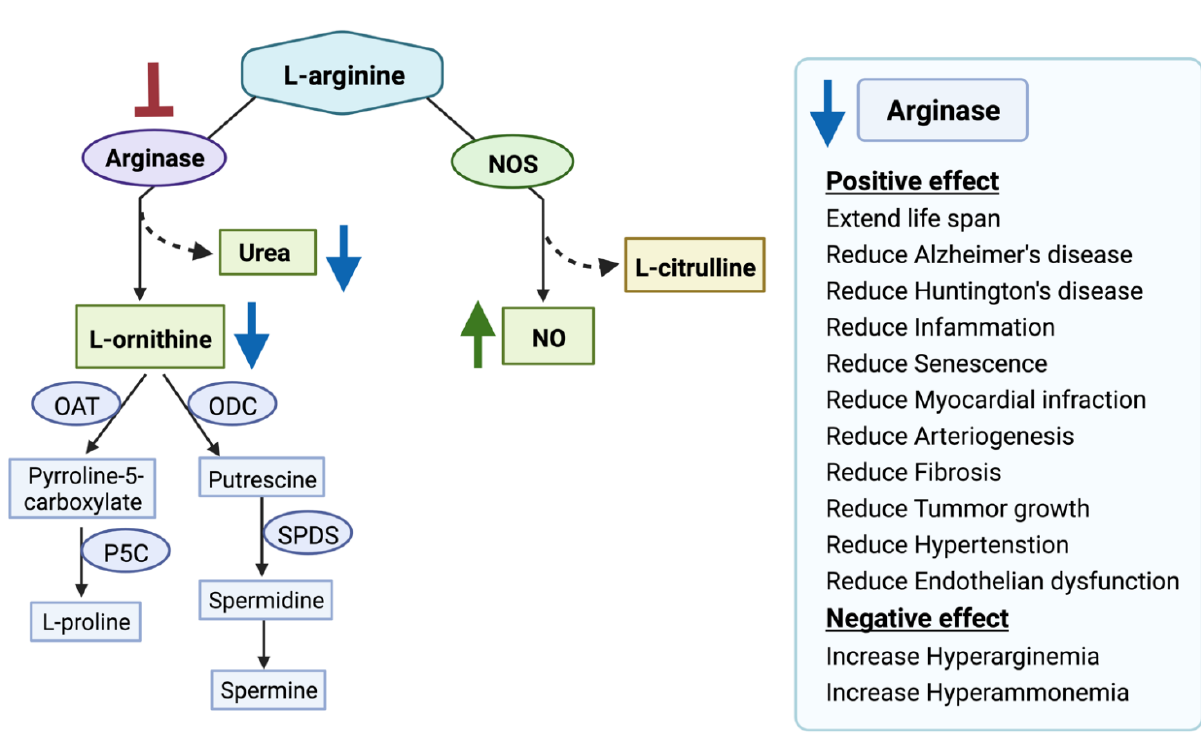
Figure 2. Arginase inhibition and its clinical relevance. Arginase inhibition results in increased nitric oxide (NO) production and decreased L-ornithine and urea production. Nitric oxide synthases (NOS), ornithine aminotransferase (OAT), ornithine decarboxylase (ODC), ∆ 1-pyrroline-5-carboxylate synthase (P5C), spermidine synthase (SPDS), spermine synthase (SPMS). The red blunt arrow shows inhibition, the green arrow represents elevated levels of the substances; blue arrows designate reduced ones.